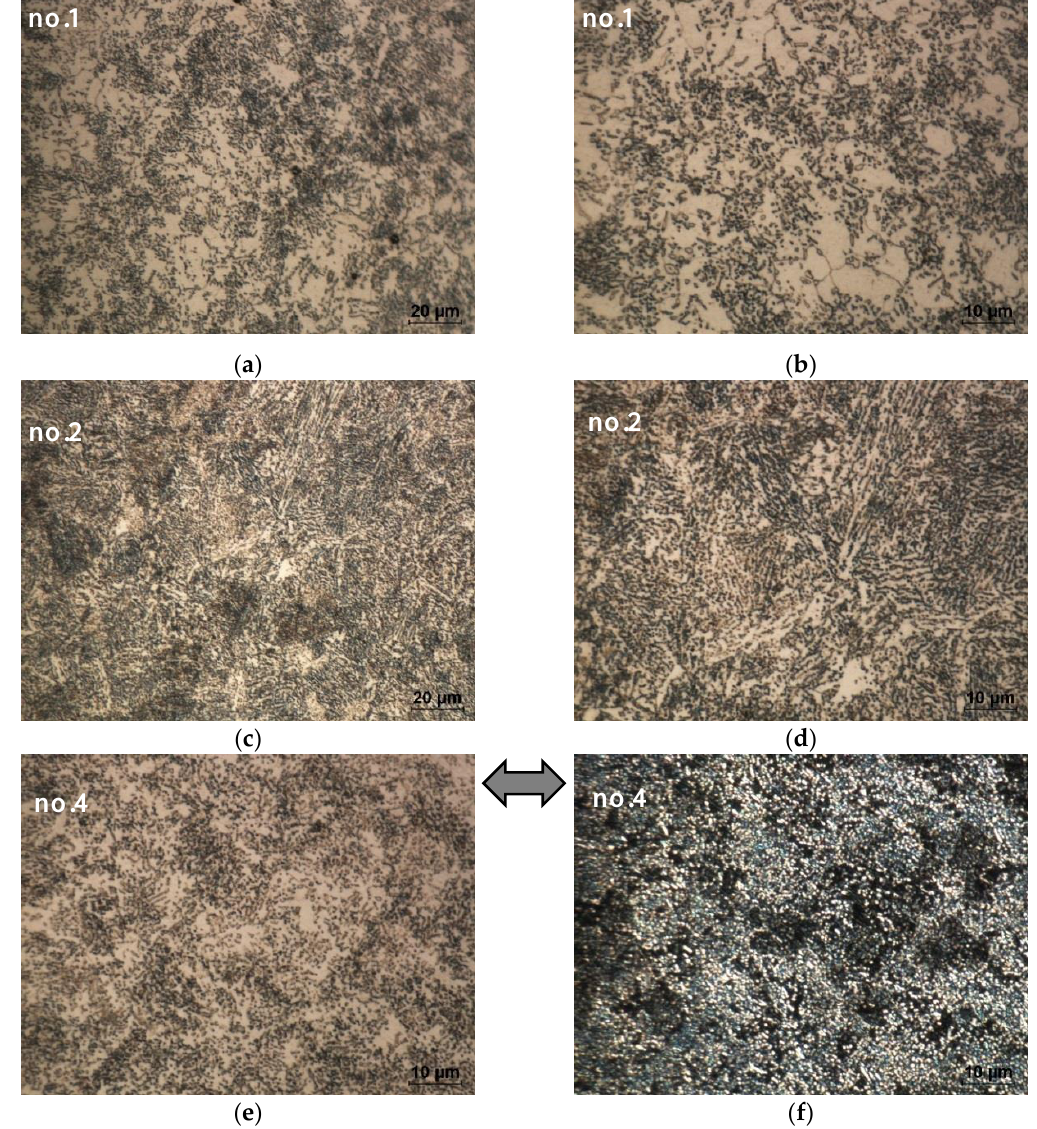
Figure 3. Microstructure of annealed 42CrMo4 steel with selected heat treatment schemes: ( a – e ) bright field technique; ( f ) area from ( e ) image captured by dark field technique (dark areas—ferrite, bright—cementite). LOM, 500× and 1000×, etched with Nital agent.